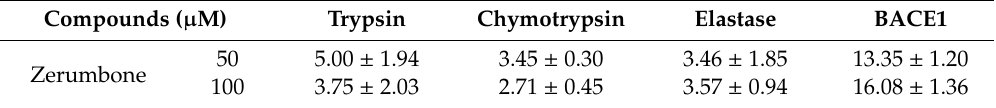
Table 2. The inhibitory activity (%) 1 of zerumbone against serine proteases and BACE1. Compounds (µM)